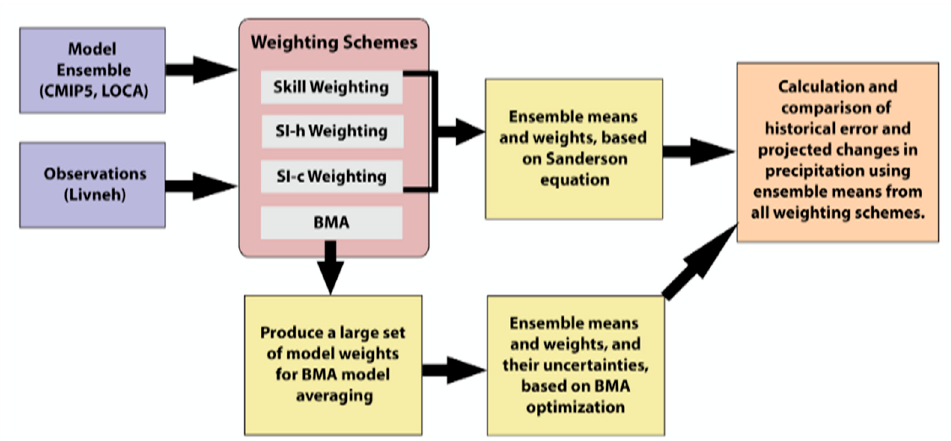
Figure 2. Flowchart showing the process of analysis with weighting schemes. The skill weighting uses only the historical skill. The SI-h uses the historical skill and independence is used to determine model weights. The SI-c weighting uses the historical skill and the independence of the projected change signal to determine model weights. Bayesian Model Averaging (BMA) explicitly accounts for both skill and independence during the optimization process. Results from the weighting schemes are compared to the results from the unweighted LOCA and CMIP5